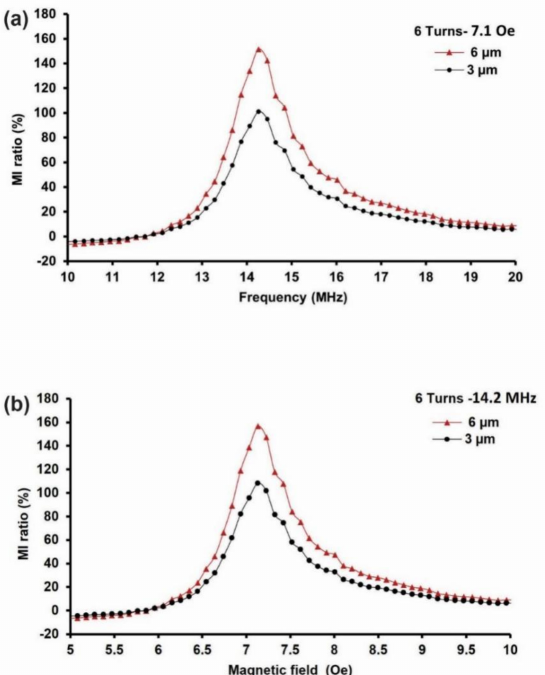
Figure 5. Results of the 6-turn MI biosensor based on different film thicknesses. ( a ) Frequency depen- dence of the MI ratio at 7.1 Oe. ( b ) Magnetic field dependence of the MI ratio obtained at 14.2